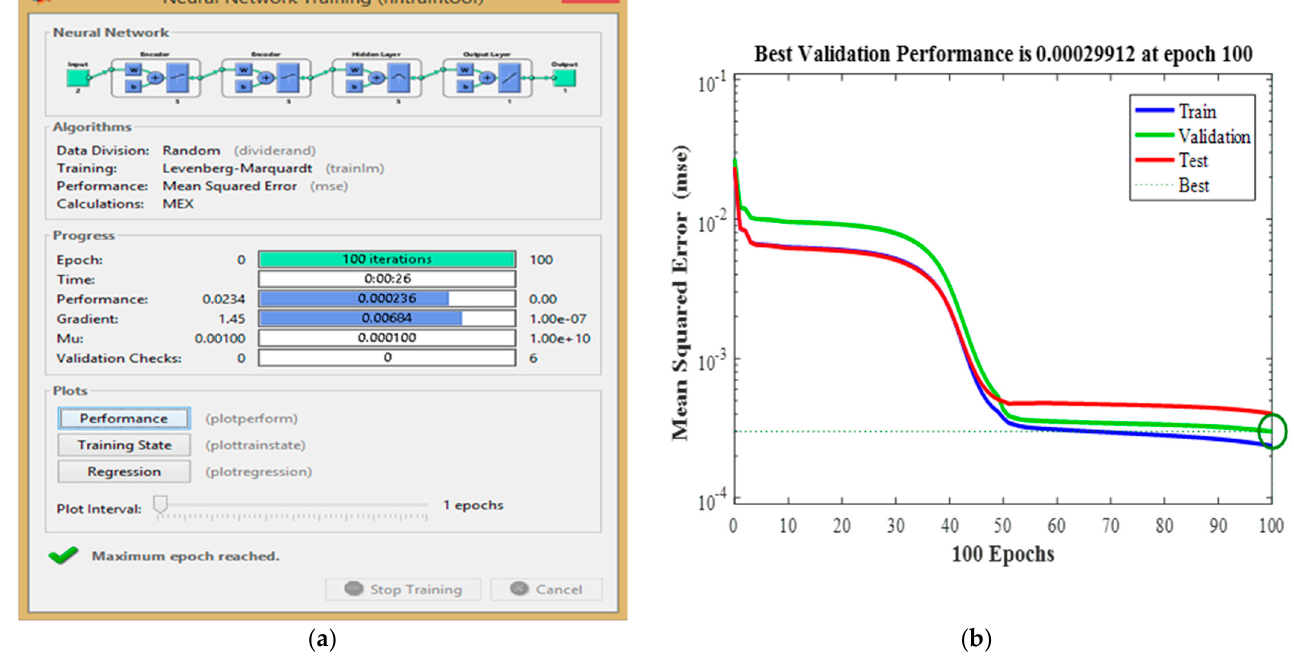
Figure 10. ANN learning progress of active power controller and its evolution training, ( a ) training GUI, ( b ) training performance using MSE.